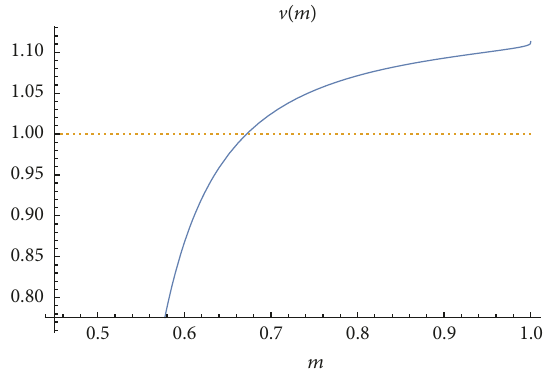
Figure 6: Velocity V (𝑚) (42) of solution (4) as function of 𝑚 .